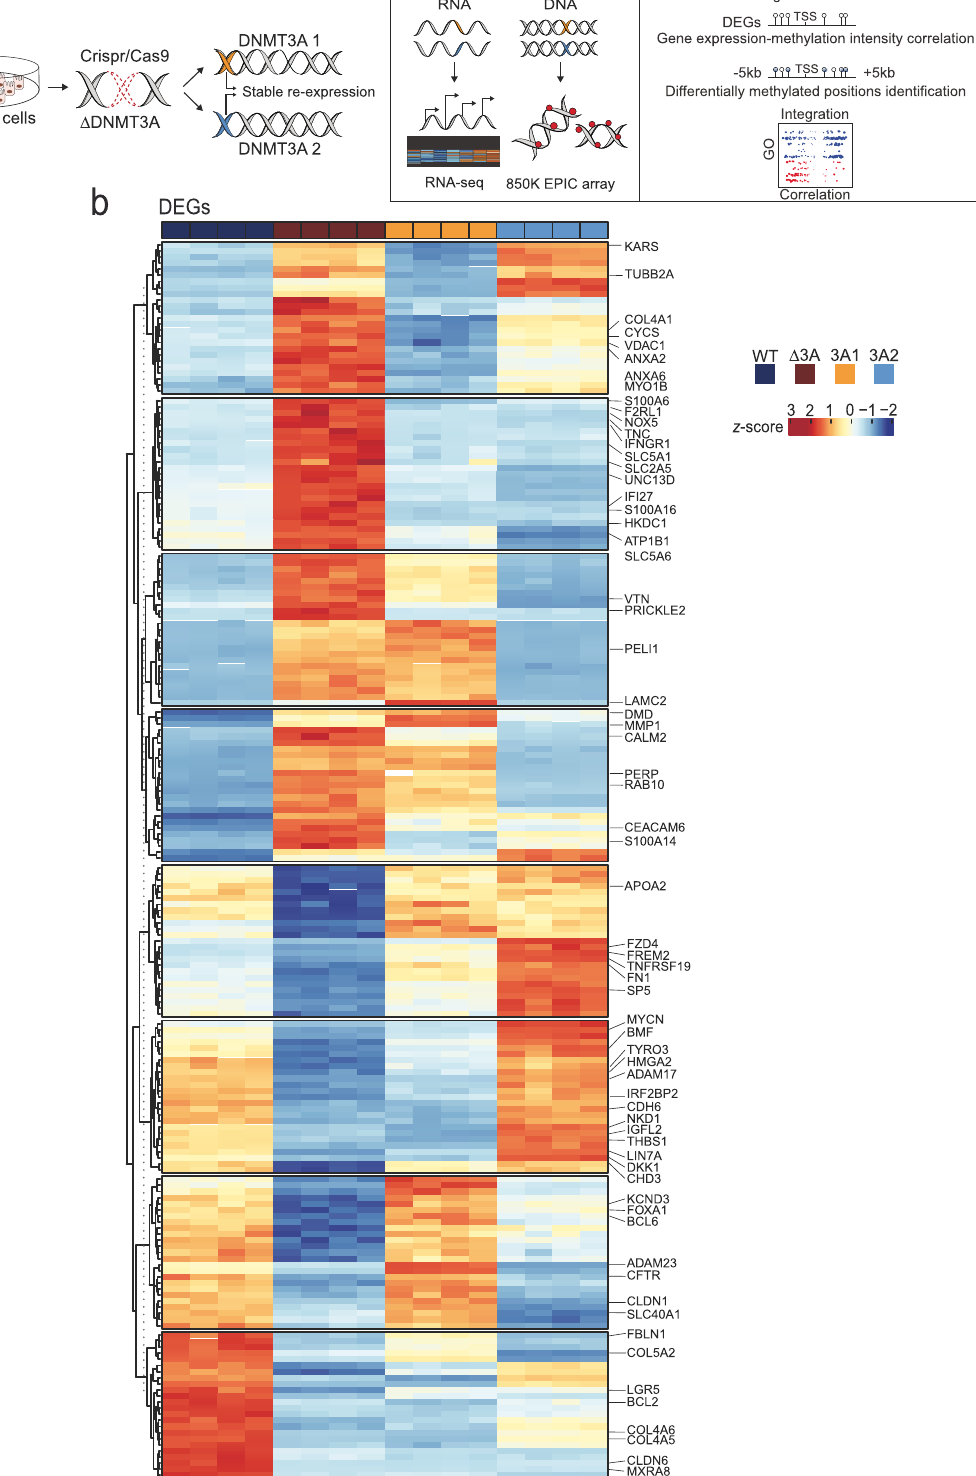
differentiallyexpressed genes(DEGs)ofWT, Δ DNMT3A,DNMT3A1, and DNMT3A2 cell lines ( n =4). Scaled gene expression/methylation intensity across all samples are